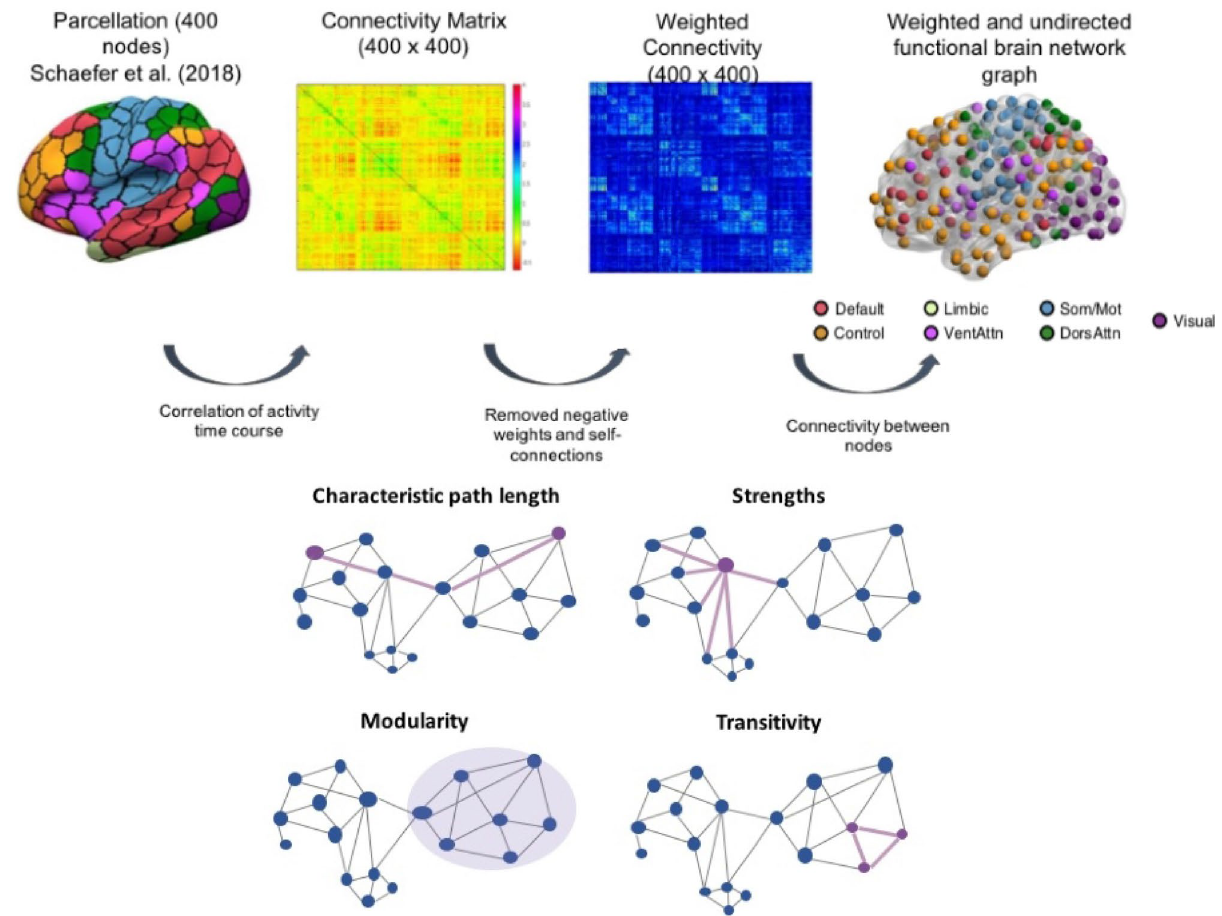
Figure 1. Schematic representation of brain network construction using graph theory analysis. After pre- processing, the brain was divided into different parcels using the Schaefer et al. (2018) parcellation scheme. Subsequently, activity time course was extracted from each region to create the correlation matrix. We used the correlation matrix and removed all the self-connected and negative weights to derive a corresponding weighted undirected brain network matrix and functional brain network graph. Lastly, we used the network matrix to calculate the sets of topological graph theory